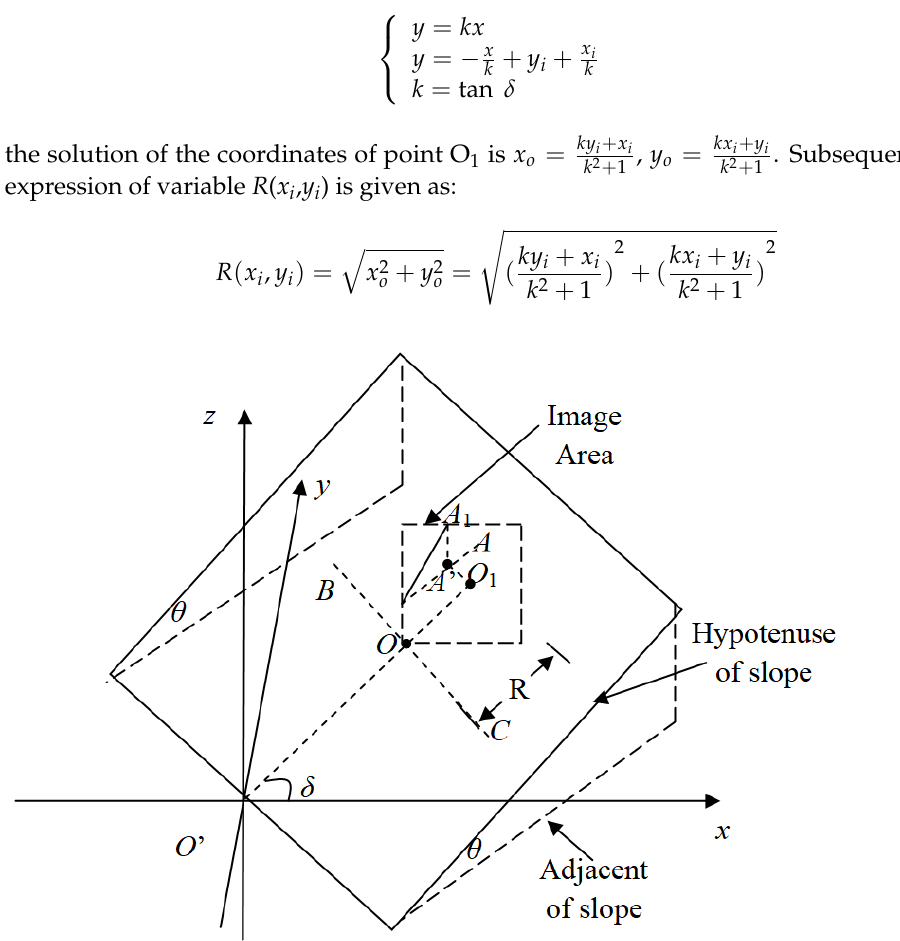
Figure 4. Ordinary slope model.